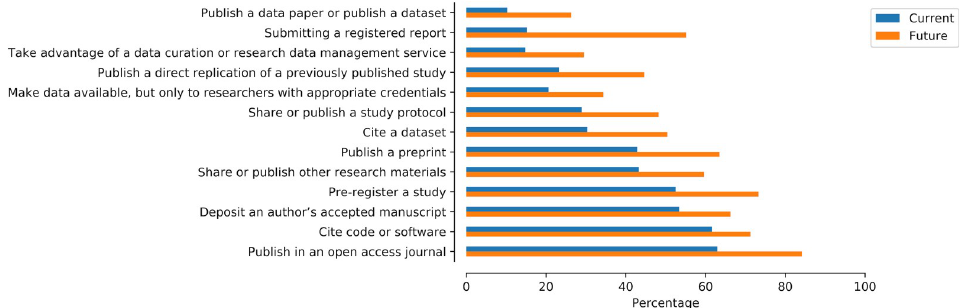
Fig 2. Current and future adoption of emerging publication practices. Percentage of participants who have (blue) and plan to (orange) adopt a range of scholarly communications practices.